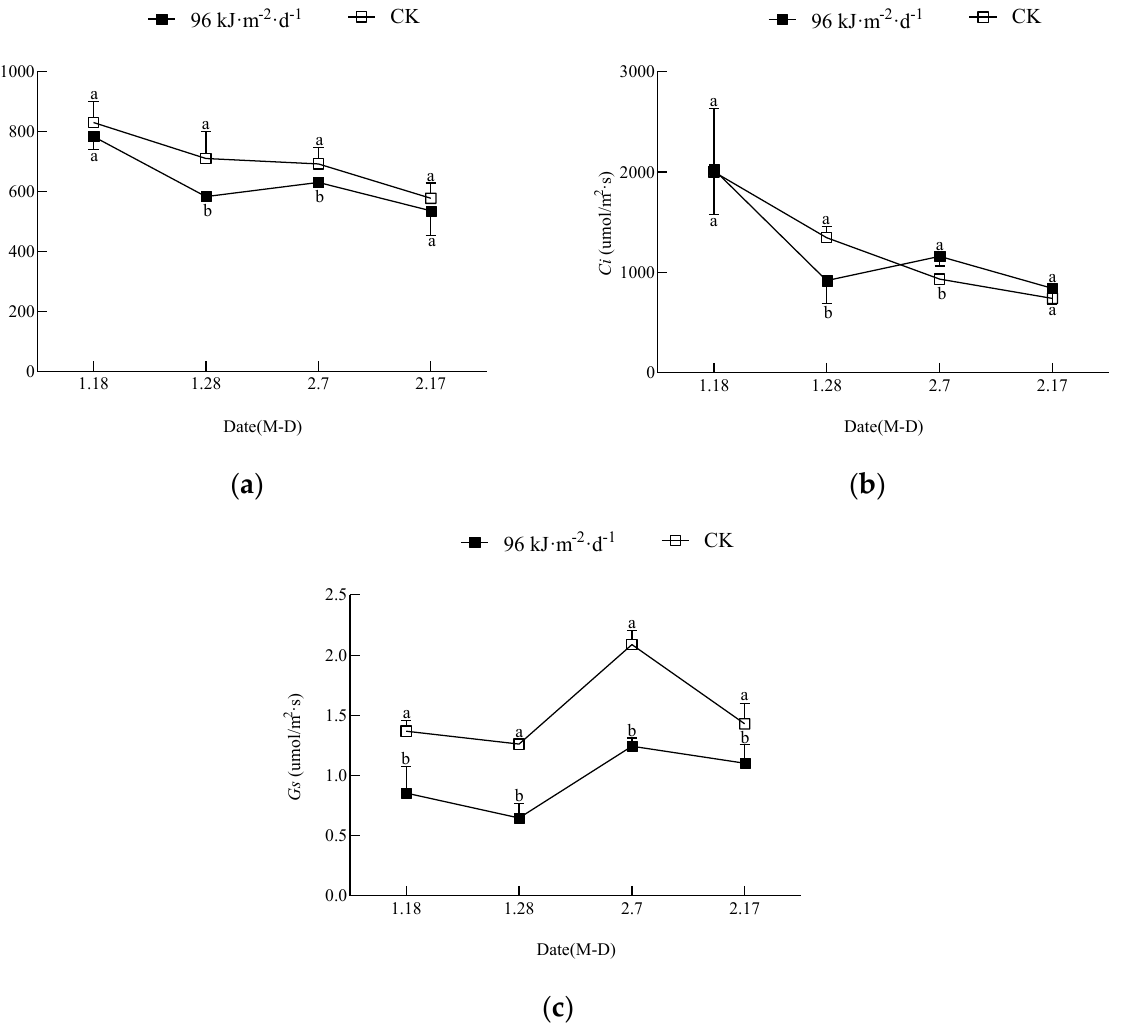
Figure 2. The effect of enhanced UV − B radiation on the photosynthetic rate, intercellular carbon dioxide content ratio, and stomatal conductance in leaves: ( a ) Pn, the net photosynthetic rate; ( b ) Ci, the intercellular CO 2 concentration; ( c ) Gs, the stomatal conductance. The same scheme applies to the figures below.